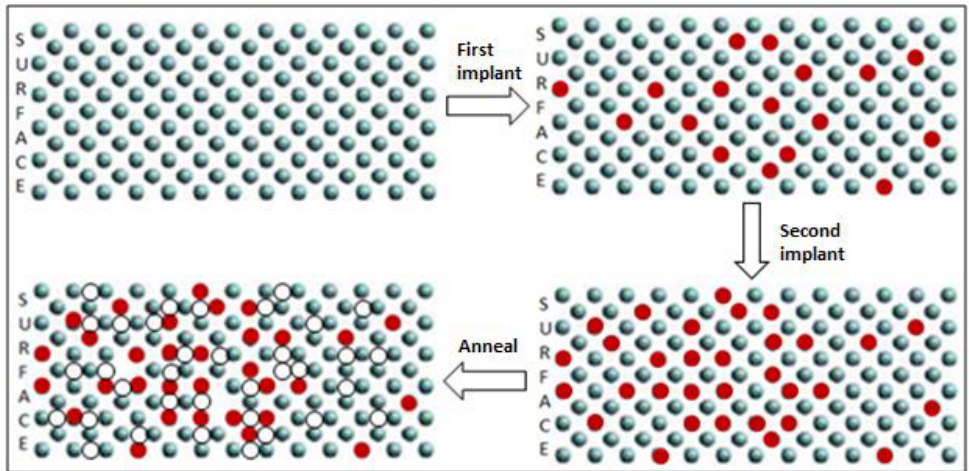
Figure 3. PL spectrum of samples A, B, C and D at 80 K. Sample A is the reference sample without ion implantation. Sample B is implanted with 30 keV of carbon ions, whereas samples C and D have double implantation of 30/10 and 50/20 keV of carbon ions, respectively. FWHM for the highest peak of sample C is 32 nm (29 meV). The inset shows the peak emission in sample A. The laser power was 200 mW.